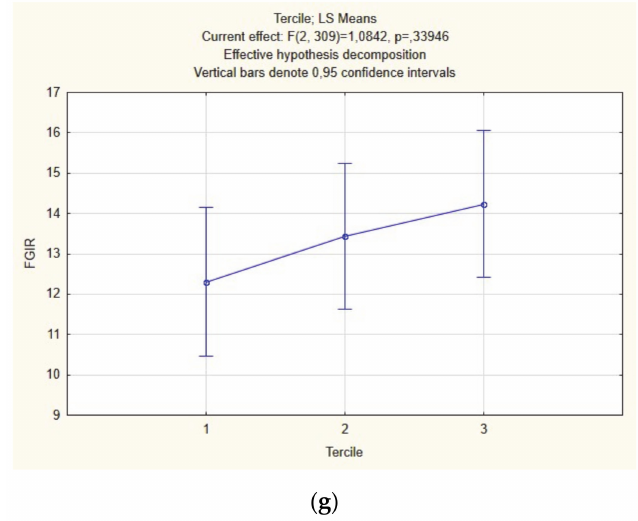
Figure 1. Intergroup comparison between terciles of free testosterone index (FTI) ( a ), menses per year (MPY) ( b ), luteinizing hormone (LH) ( c ), Ferrimann–Gallway score (FG) ( d ), body-mass index (BMI) ( e ), QUICKI ( f ), FGIR ( g )